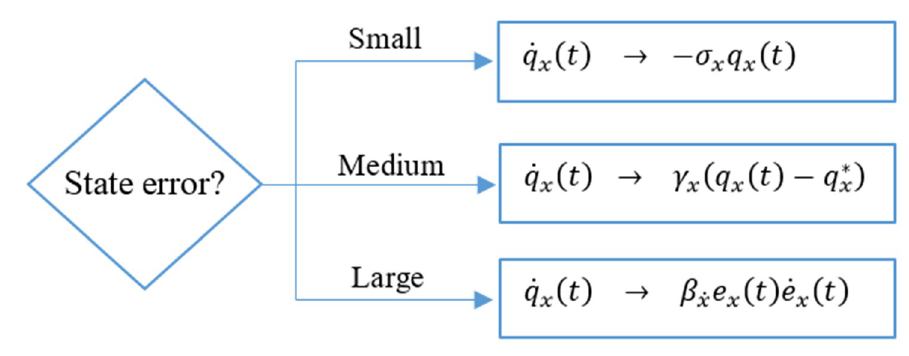
Fig 3. Flow chart for the improved weight–adjustment